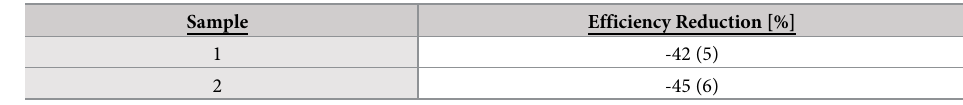
Table 2. Efficiency reduction of Model 1 respirator.